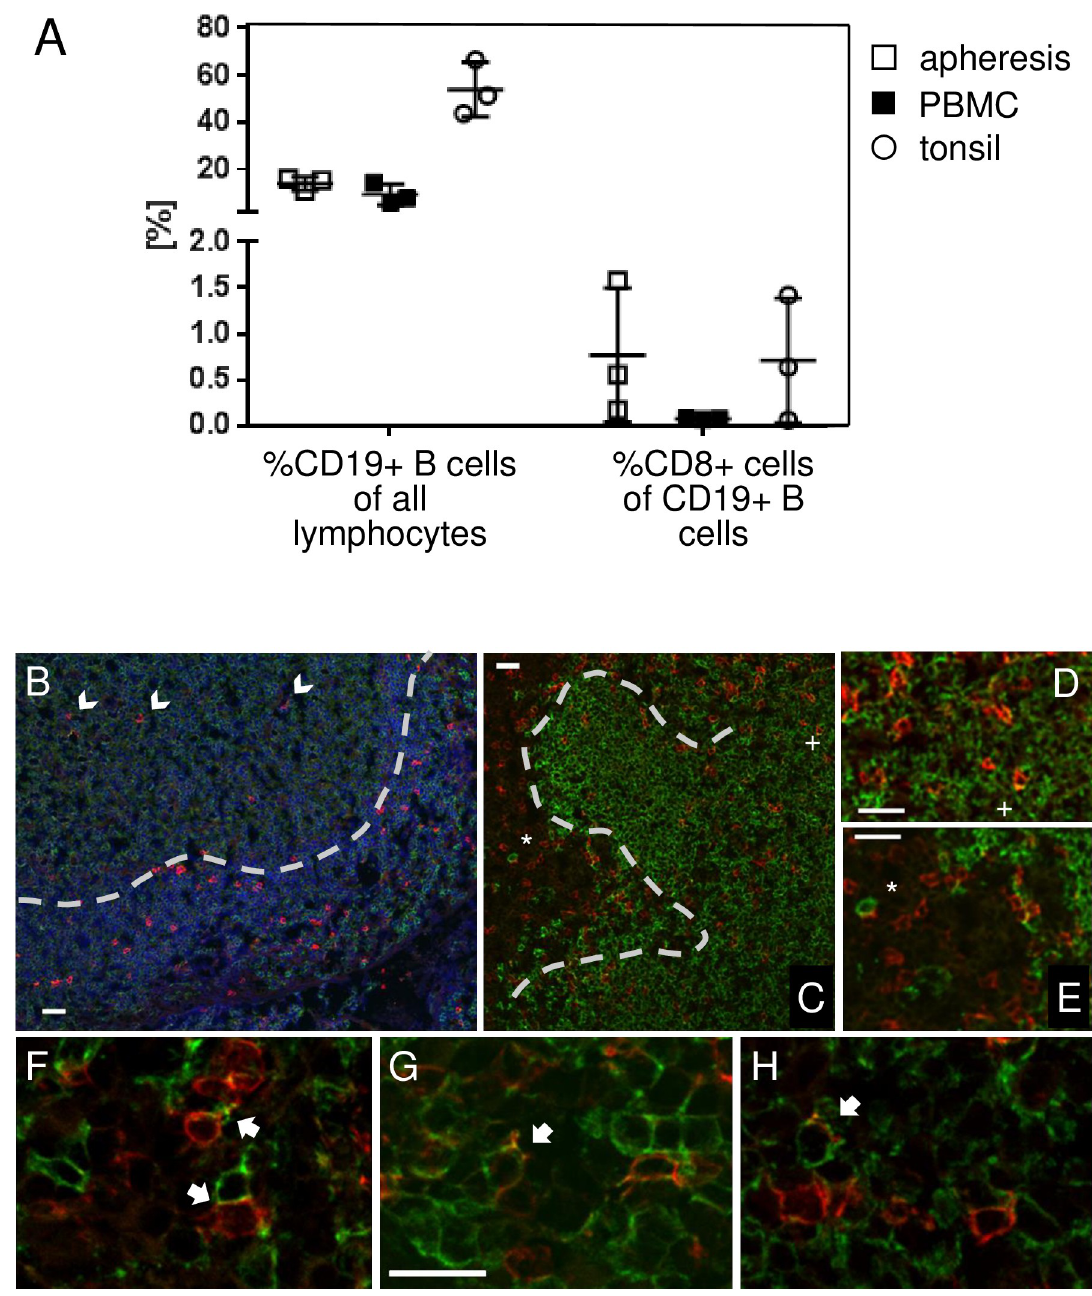
Fig 2. CD8 positive B cells in human tonsil. (A) Subsets were enumerated from apheresis material (open squares), normal peripheral blood (black squares), and from tonsils (open circles) from three donors each. Average and high / low ranges are indicated by lines. (B) Localization of CD8+ T (red) and CD20+ B cells (green) in human tonsils. CD8+ T cells are rare in the germinal centers (GC; arrowheads in panel B), and appear mostly in the mantle zone (MZ; separated by dashed line from the GC). B cells carrying CD8 staining in their membranes were identified in the MZ and in the interfollicular region (panel C, marked with a + and � , respectively; shown at higher magnification on panels D and E). Examples of stable B—CD8+T cell contacts (arrowheads, F), and B cells integrating CD8-carrying patches in their membranes (arrowheads, panels G and H) were identified in the mantle zone. White bars indicate 20um.